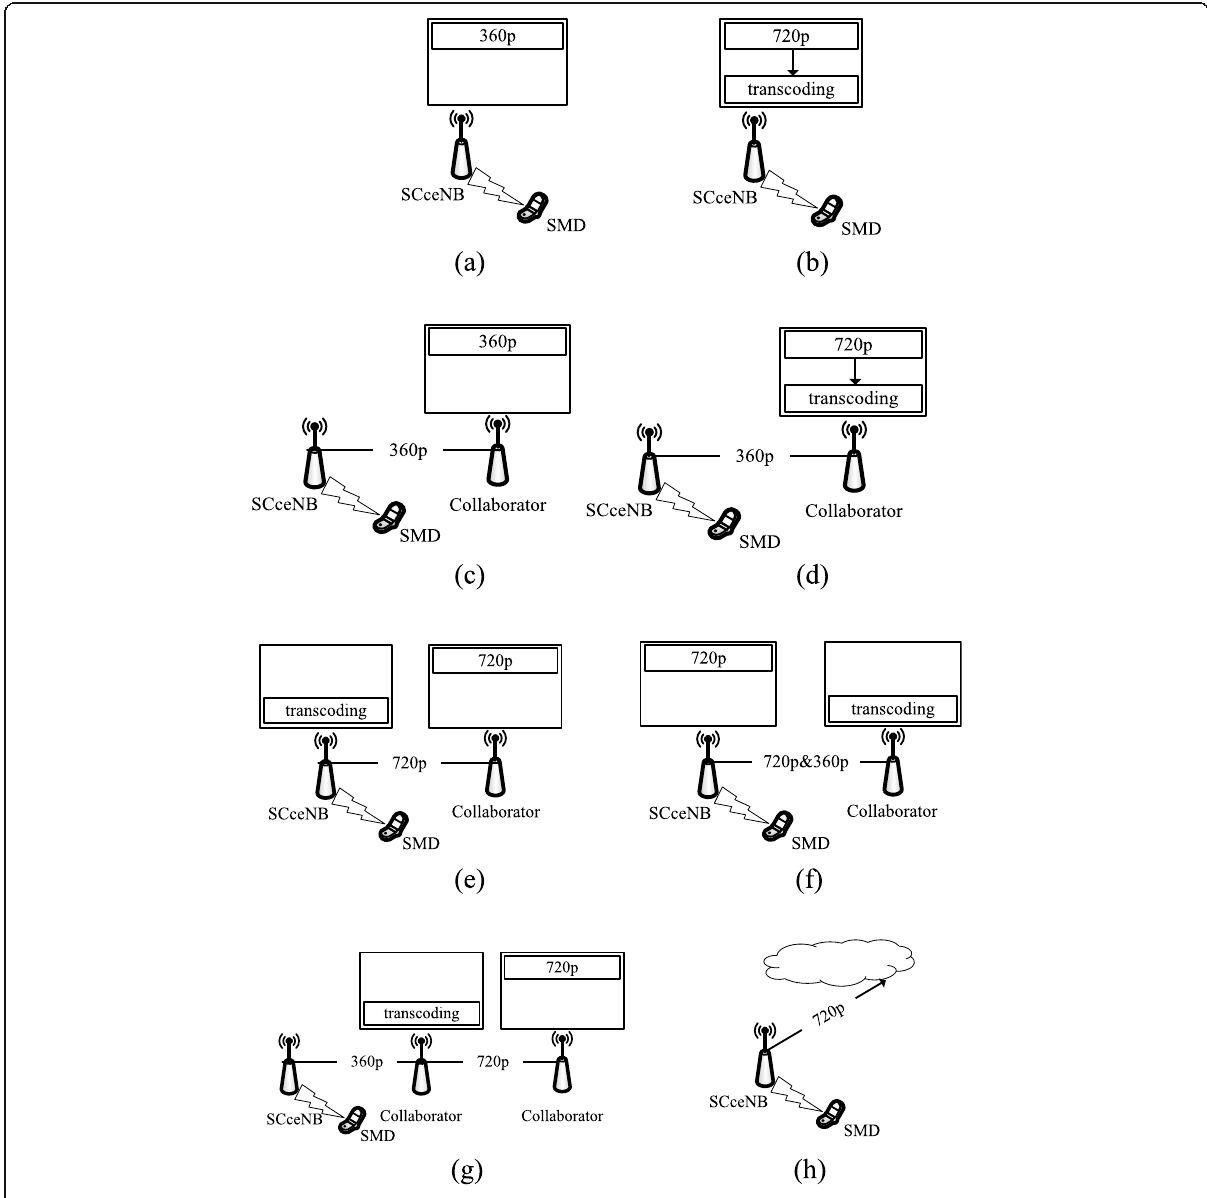
Fig. 4 All possible multi-edge collaborative computing video caching and distribution